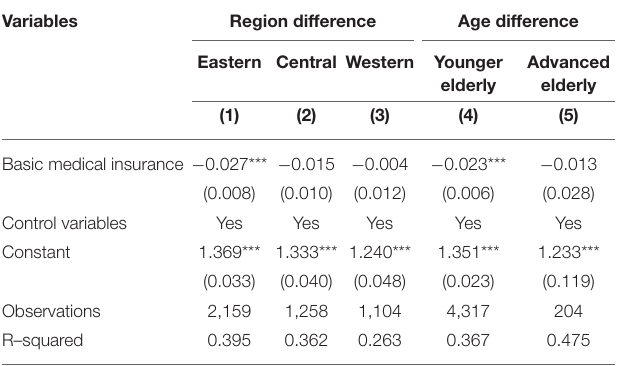
TABLE 5 | Results of heterogeneous analysis. TABLE 6 | Results of mediating